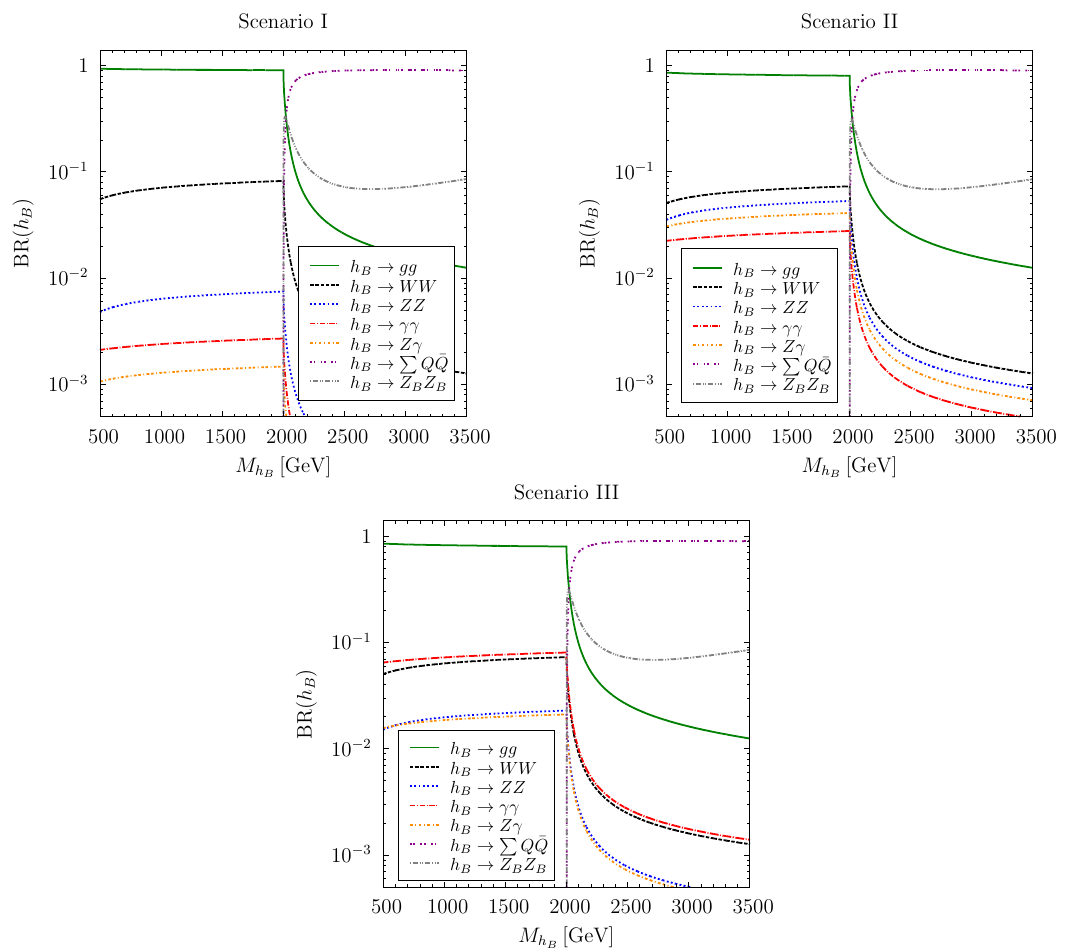
Figure 2 . Branching ratios of the baryonic Higgs as a function of its mass M mixing angle (cid:18) B . We use M Z = 1 TeV, v B = 20 TeV and m Q = 1 B